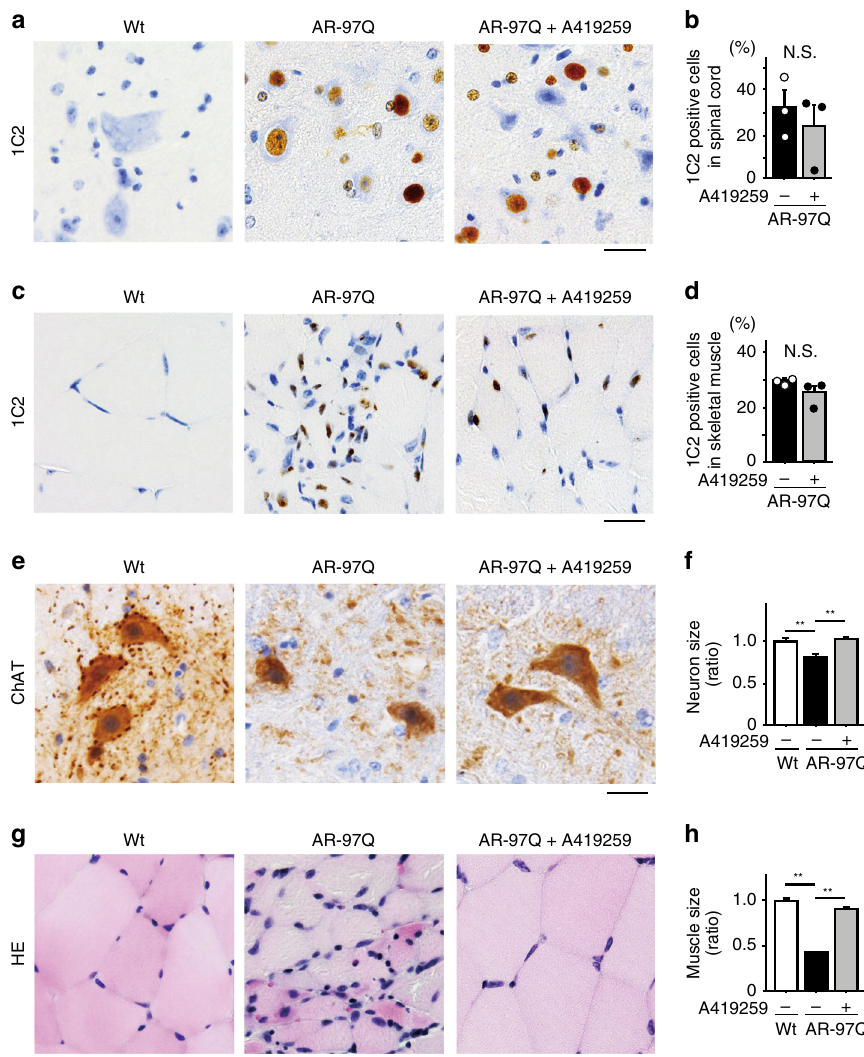
Fig. 5 Effect of A419259 on the histopathology of AR-97Q mice. a – d Immunohistochemical staining of the spinal cord ( a , b ) and skeletal muscle ( c , d ) from 13-week-old mice with an antibody against polyglutamine (1C2) and quantitative analysis of the staining. e , f Immunostaining for ChAT in spinal cord samples from 13-week-old mice. g , h HE staining of skeletal muscle ( g ) and quantitation of the muscle fi ber size ( h ) in 13-week-old mice. Quantitative analyses were performed on sections from n = 3 animals per group. Error bars indicate s.e.m. Statistical analyses were performed using the unpaired two- sided t -test ( b , d ). ** p < 0.01, ANOVA with Dunnett ’ s test ( f , h ). N.S., not signi fi cant. Scale bars: 25 µ m ( a , c , e , g ). Source data are provided as a Source Data fi le ( b , d , f , h